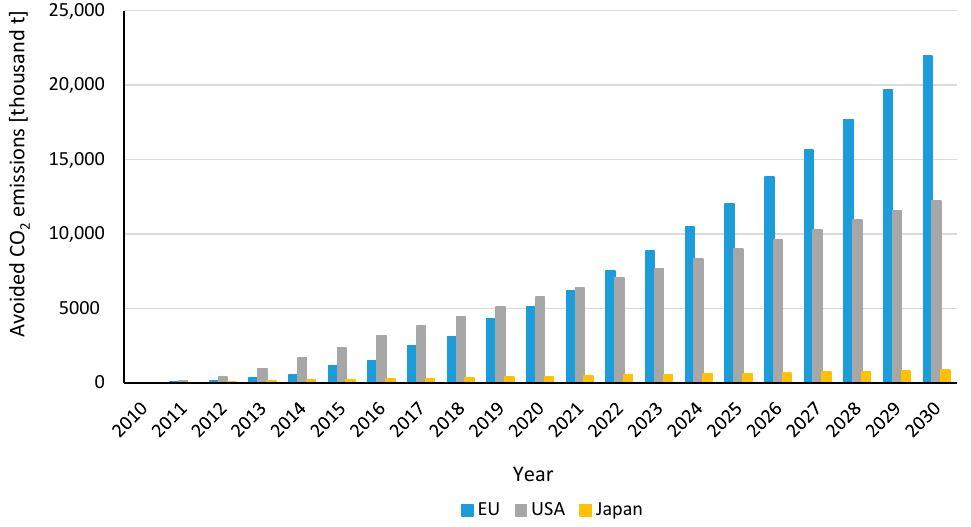
Figure 6. Tank-to-wheel CO 2 emissions avoided on an annual basis in the EU, US and Japan.